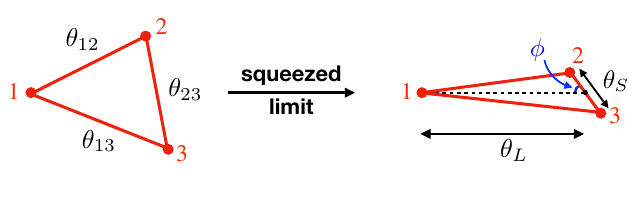
Figure 1. Symmetric parametrization of the squeezed limit, as described in the text. This parametrization ensures that linear power corrections associated with an asymmetric parametriza- tion are